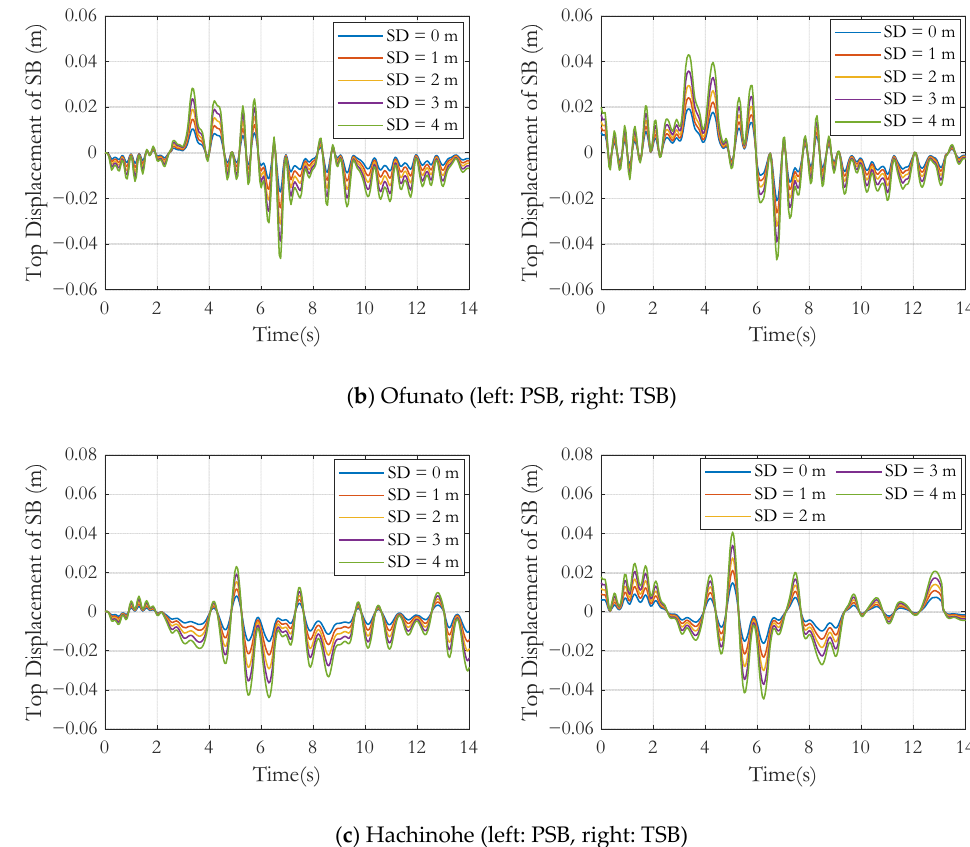
Figure 18. Top displacement of SB with scour under earthquake.